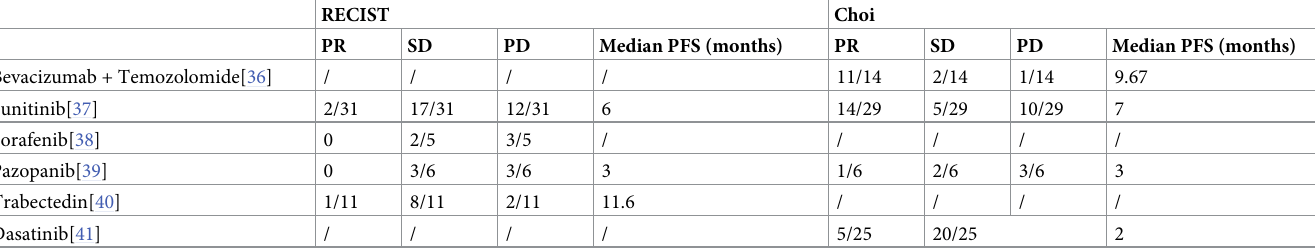
Table 2. Summary of outcomes of targeted drug treatment of progressive solitary fibrous